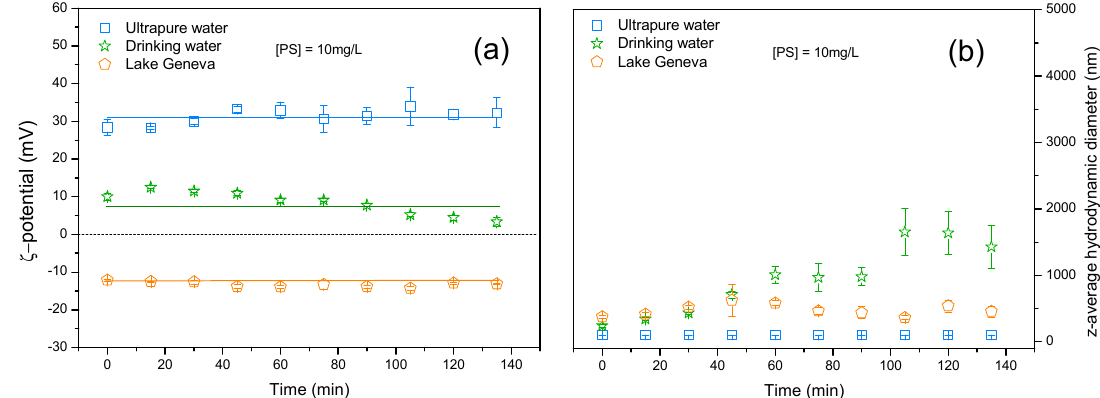
Figure 9. (a) ζ potential and ( b) z-average hydrodynamic diameter variation of amidine PS nanoplastic particles as a function of time in ultrapure at pH = 8.0 ± 0.1, drinking and Lake Geneva waters at their natural pHs. Charge reversal is observed when PS nanoplastic particles are introduced in Lake Geneva water. Natural organic matter (NOM) coating is expected and results in limited aggregation of nanoplastics.